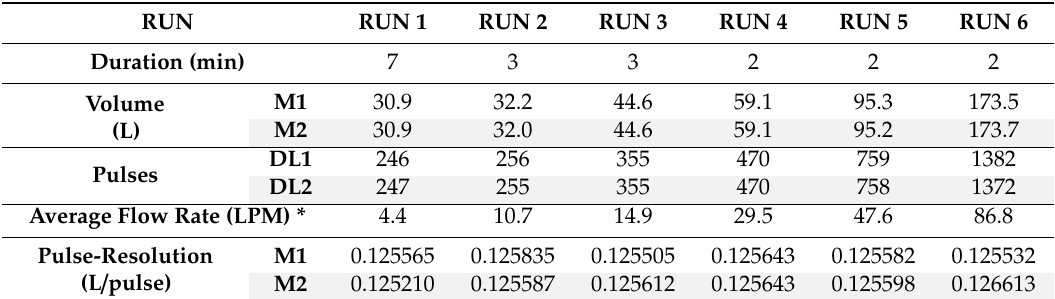
Table 5. Calibration results for the CIWS datalogger using two 1 in Neptune T-10 meters. RUN RUN 1 RUN 2 RUN 3